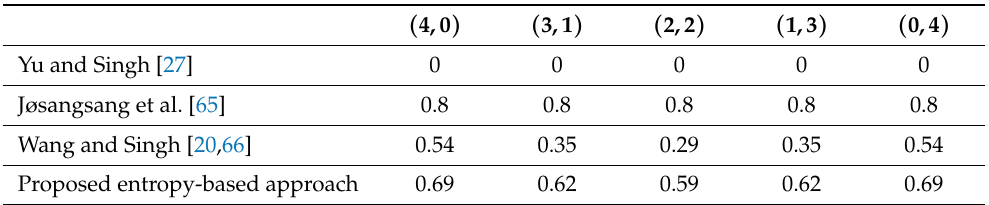
Table 3. Certainty computed by different approaches for different satisfactory degrees with a fixed amount of interactions at